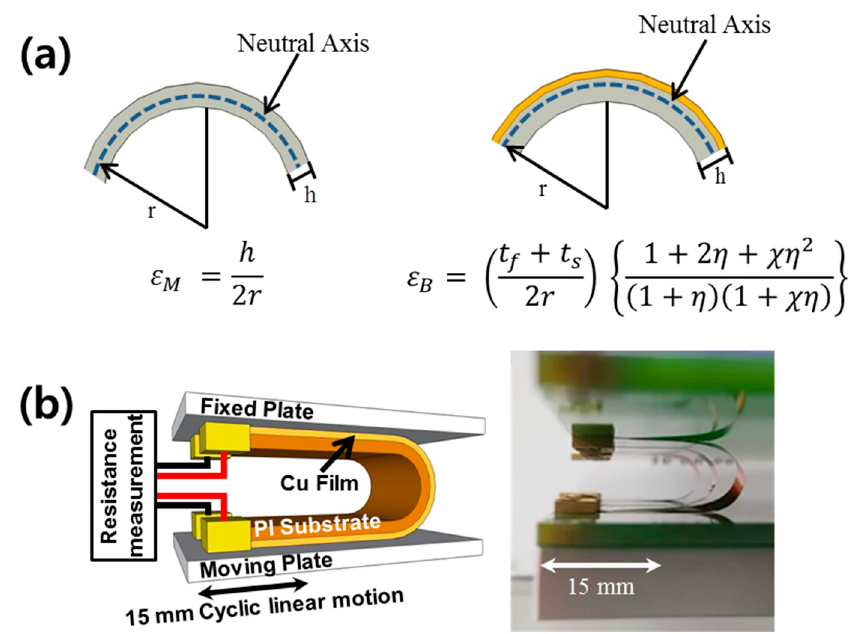
Figure 1. ( a ) Schematic illustrations and equations for calculating bending strain using monolayer and bilayer models. ( b ) Schematic and image of a bending fatigue test and an electrical resistance monitoring system.